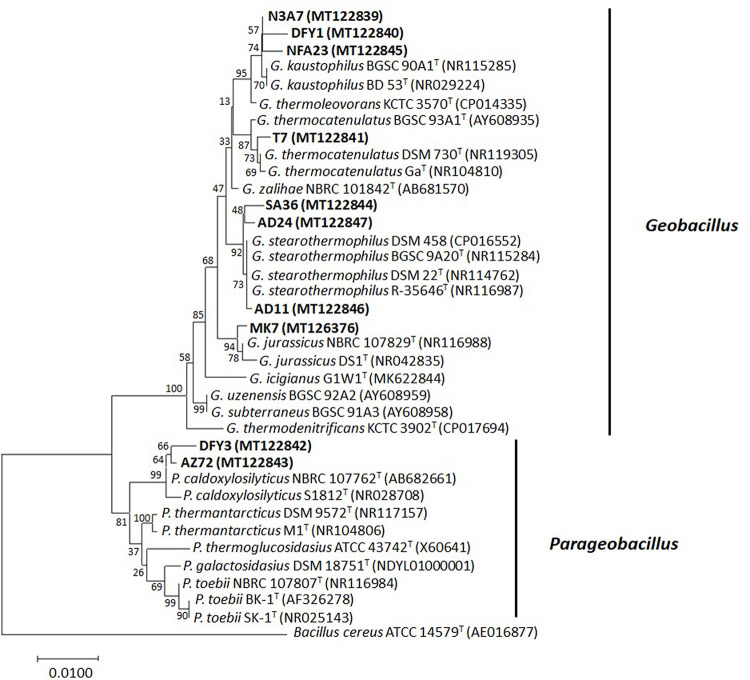
The 16S rRNA gene phylogenetic analysis of bacterial strains. The evolutionary history was inferred using the neighbor-joining method. The evolutionary distances were computed with p-distance method and 1,000 bootstrapped. The strains were aligned with closest relatives from GenBank. The accession numbers indicated within the bracket. The optimal tree with the sum of branch length = 0.18041597 was shown. The analysis involved 37 nucleotide sequences. There were a total of 1,204 positions in the final dataset. Bacterial strains used in this study are in bold. Sequence from Bacillus cereus ATCC 14579T was used as an outgroup.